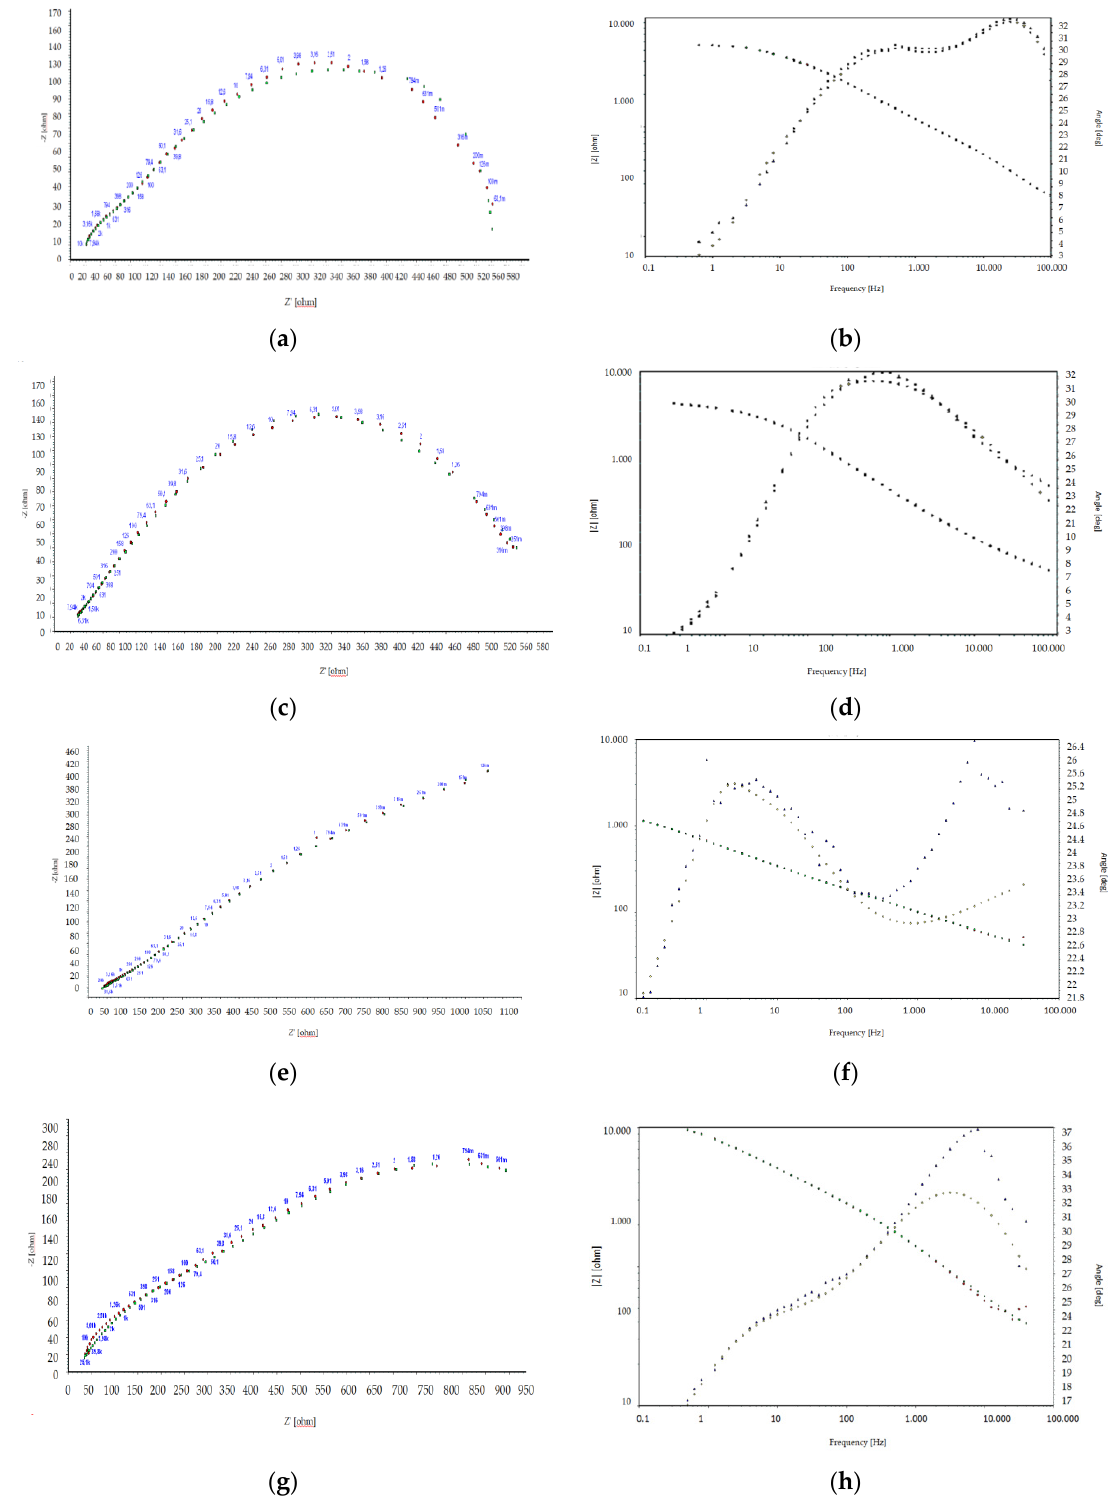
Figure 6. Nyquist and Bode plots and equivalent circuit of the phosphate steel surface ( a , b ) and phosphate steel surface with Ni 2+ ions ( c , d ), Ce 3+ ions ( e , f ), and Ti 2+ ions ( g , h ) after 1h immersion in 3.5 wt.% NaCl solution.